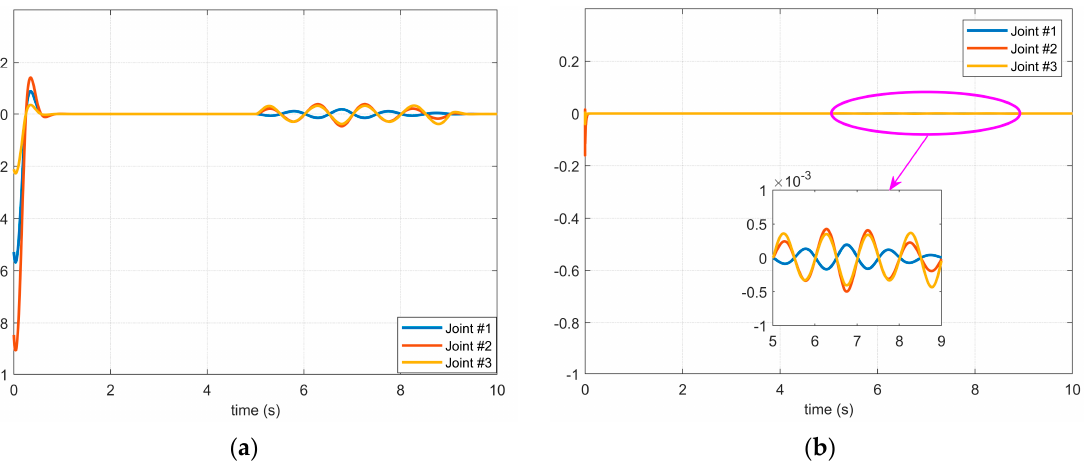
Figure 7. The effect of the 3rd disturbance on the servo motor of each axis of the manipulator: ( a ) The BKS operator is not applied. ( b ) The BKS operator is applied.